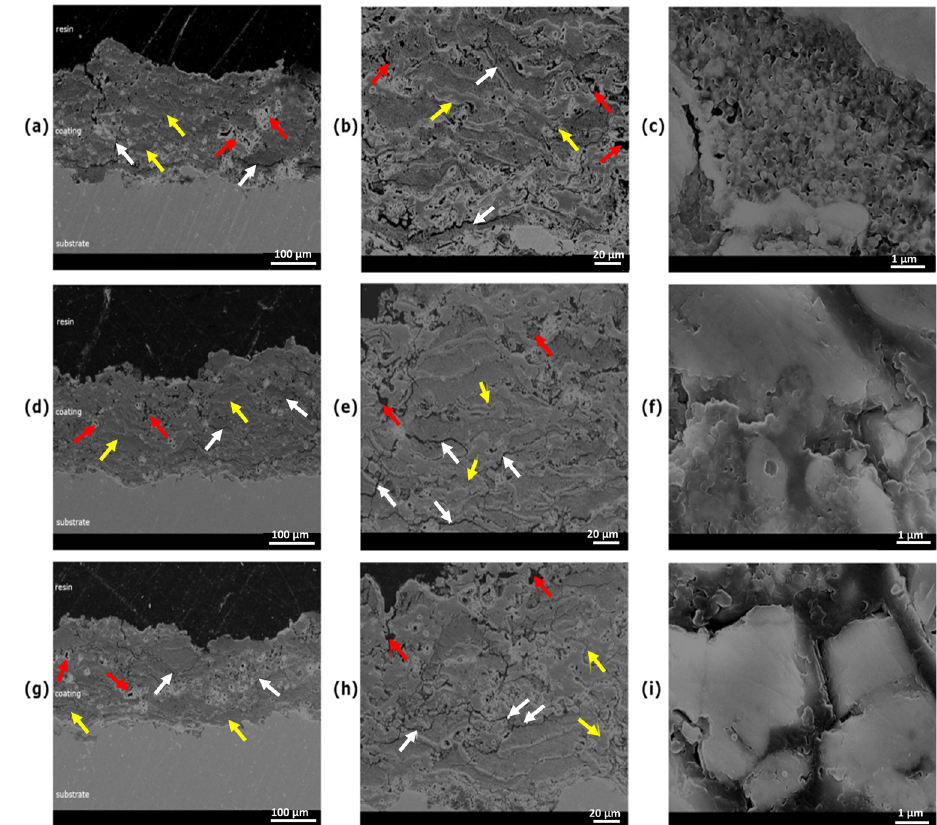
Figure 4. Microstructures of hydroxyapatite (HA) coatings ta low and high magnification; ( a – c ) HA1, ( d – f ) HA2, ( g – i ) HA3. Arrows: white–cracks, yellow–deformed lamella, red–pores.